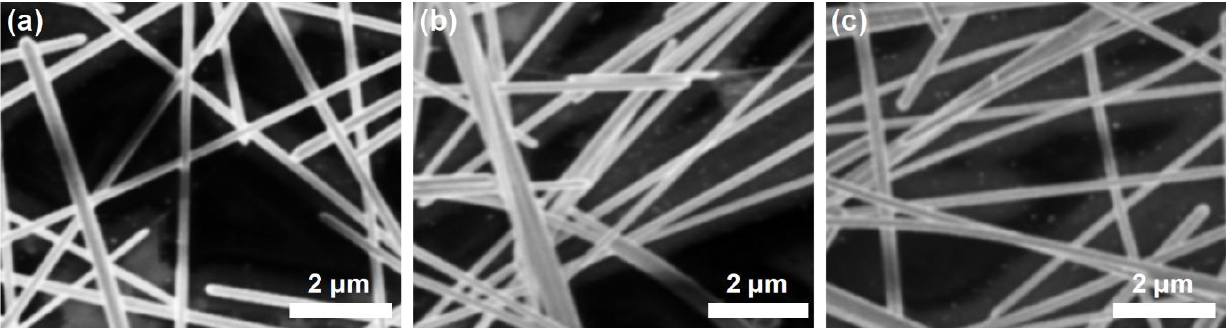
Figure 3. SEM images of Ag nanowire electrodes coated at a blade height of ( a ) 150 μm and ( b ) 350 μm with a blading speed of 10 mm/s. ( c ) SEM images of a Ag nanowire electrode coated at a blading speed of 30 mm/s with a blade height of 150 μm.